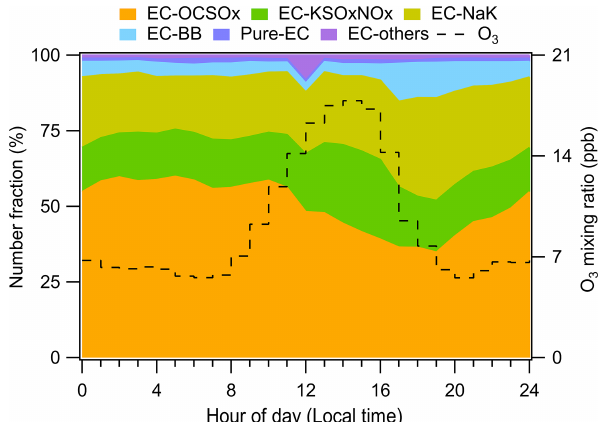
Figure 10. Diurnal patterns of number fraction of six types of el- emental carbon (EC)-containing particles and ozone (O 3 ) mixing